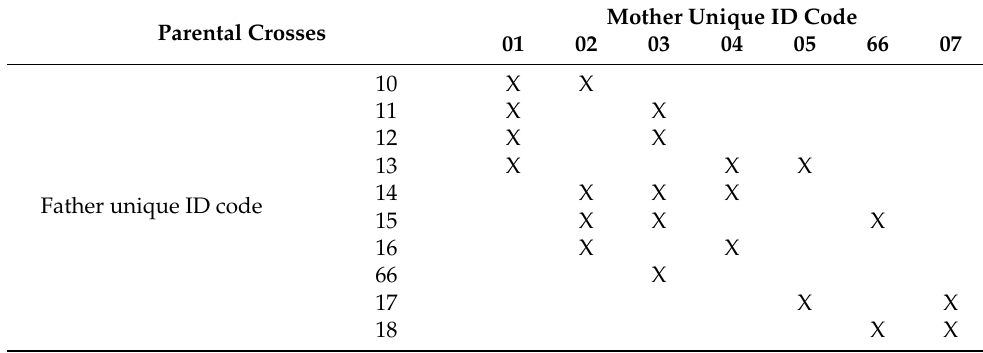
Table A1. Parents which were crossed to produce offspring. The ‘X’ mark indicates mother and father ID for the resulting offspring used in this study. Unique genotype IDs and names have been substituted for numbers. Tree 66 was used both as a mother and a father